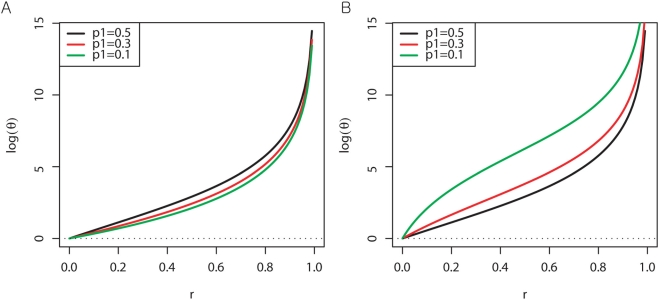
r vs log(θ), given true allele frequency.A. p2 = 0, B. p2 = 1. Log base 2.